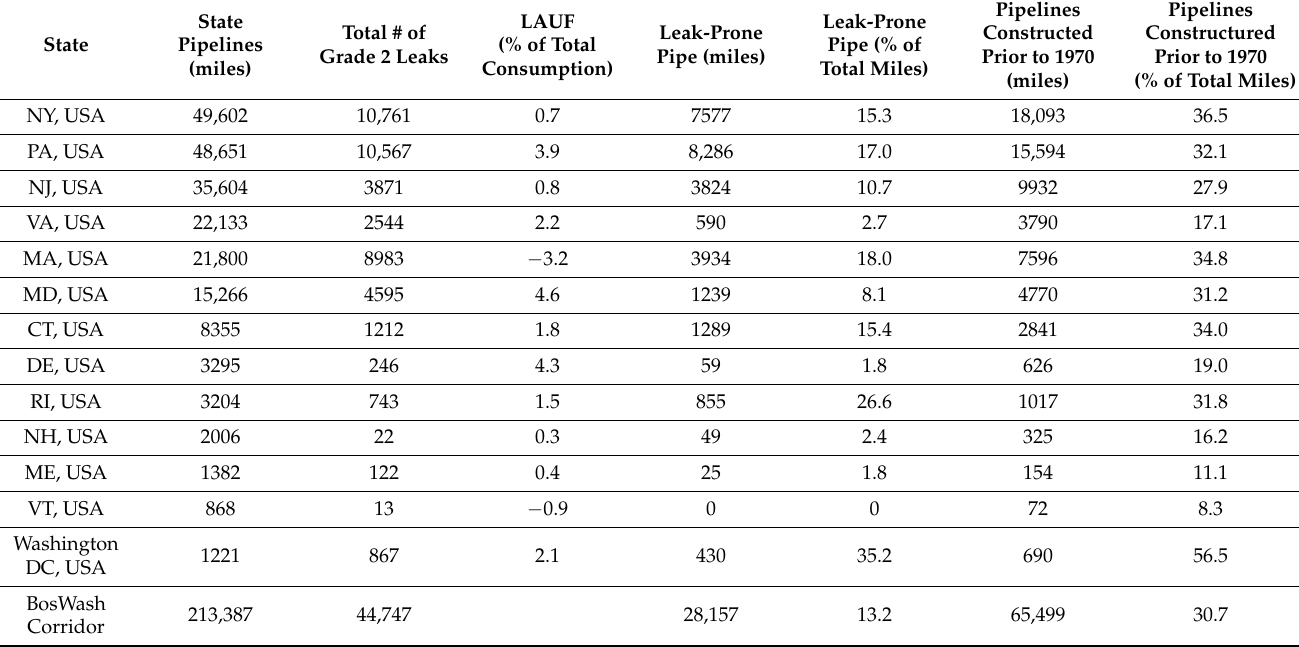
Table 2. Natural gas distribution pipeline statistics for each of the 12 states and Washington, DC in the BosWash corridor. Data reported from PHMSA in 2020 [69]. For each state, the total number of pipeline miles and the total number of Grade 2 leaks scheduled for repair is reported. A total of 2020 reports of LAUF are displayed for each state as a percent of total consumption [71]. A negative value means that supply is less than disposition. Leak-prone pipelines are defined as distribution pipelines made of bare steel or cast/wrought iron and are reported as total miles and percent of state’s total miles [70]. Total miles of pipeline in each state installed prior to 1970 is reported both as total miles and percent of state’s total miles. Each descriptive statistic and leak-prone classification is totaled for the BosWash corridor. Data are rounded to the nearest whole mile. States and utility information is sorted by the number of miles of pipeline in each state, with NY having the most, and VT having the